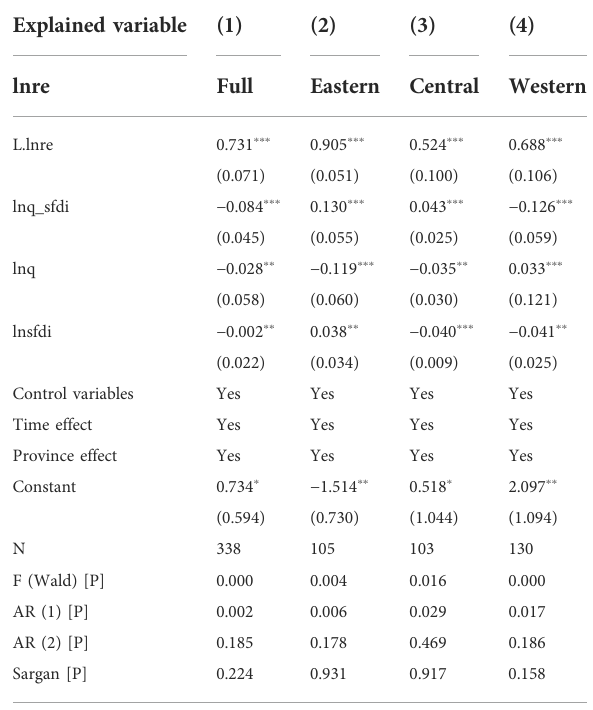
TABLE 5 Estimated results of the FDI in fl uence.